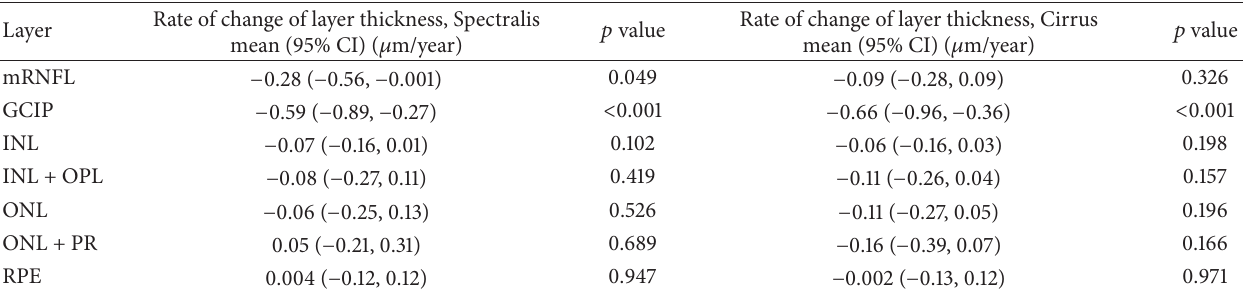
Table 4: Comparison of the rates of change of retinal layer thickness between Spectralis and Cirrus HD-OCT.